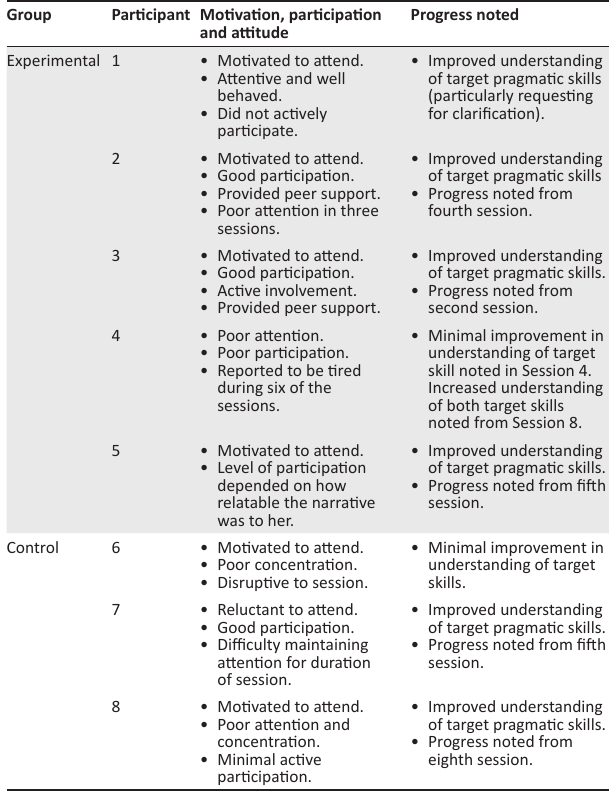
TABLE 4: Summary of qualitative data as per session